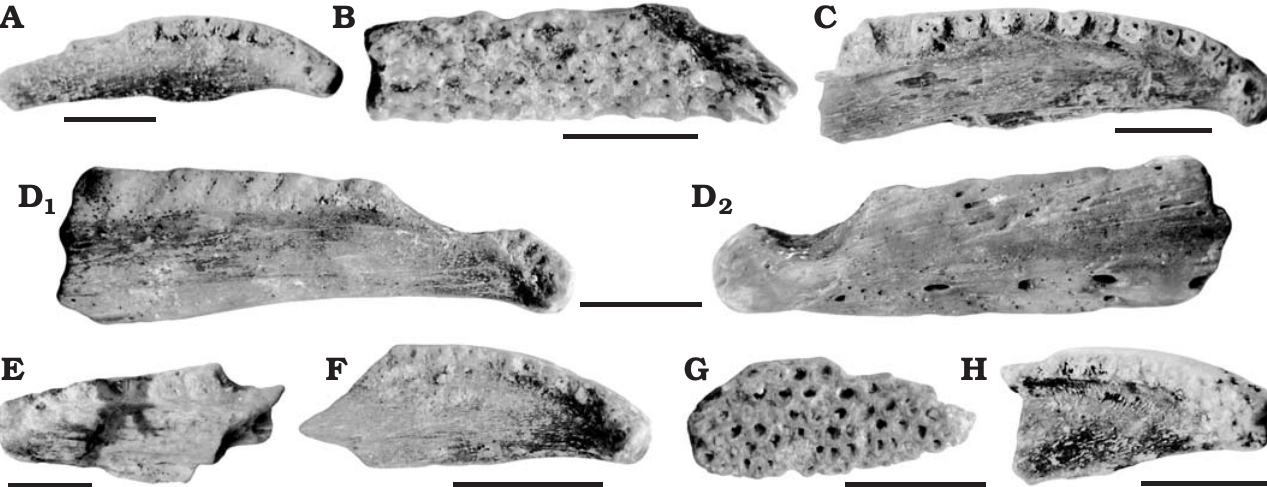
Fig. 3. Isolated elements assigned to a pike Esox moldavicus Sytchevskaya, 1974 from Southeastern Europe; Pliocene (A, C–E, G), and Pleistocene (B, F, H). A . Left dentary (NMNHU-P 45/6017), Cherevichne 2, occlusal view. B . Right palatine (NMNHU-P 41/2556), Kotlovina 3, ventral view. C . Left dentary (NMNHU-P 42/513), Kamenskoe, occlusal view. D . Left dentary (NMNHU-P 53/4248), Kryzhanovka, occlusal (D 1 ) and medial (D 2 ) views. E . Right dentary (NMNHU-P 53/4245), Obukhovka 1, occlusal view. F . Left dentary (NMNHU-P 41/2452), Kotlovina 2, occlusal view. G . Palatine fragment (NMNHU-P 53/4246), Obukhovka 2, ventral view. H . Left dentary (NMNHU-P 41/2454), Kotlovina 3, occlusal view. E, D 2 , anterior to right; C, D 1 , A, F, H, anterior to left; G, B, anterior towards top. Scale bars: E, D, 10 mm; C, G, F, H, B, 5 mm; A, 2